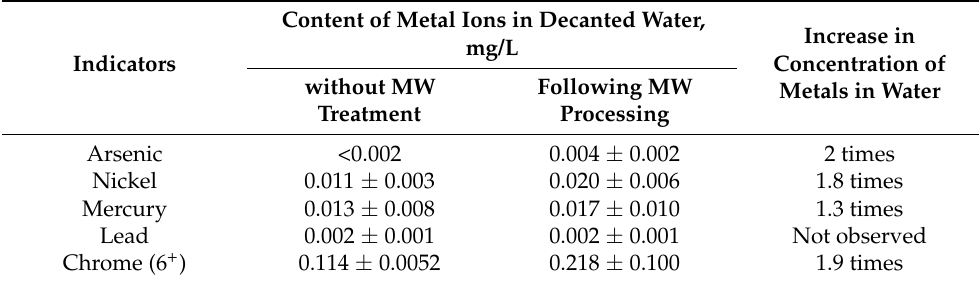
Content of Metal Ions in Decanted Water,